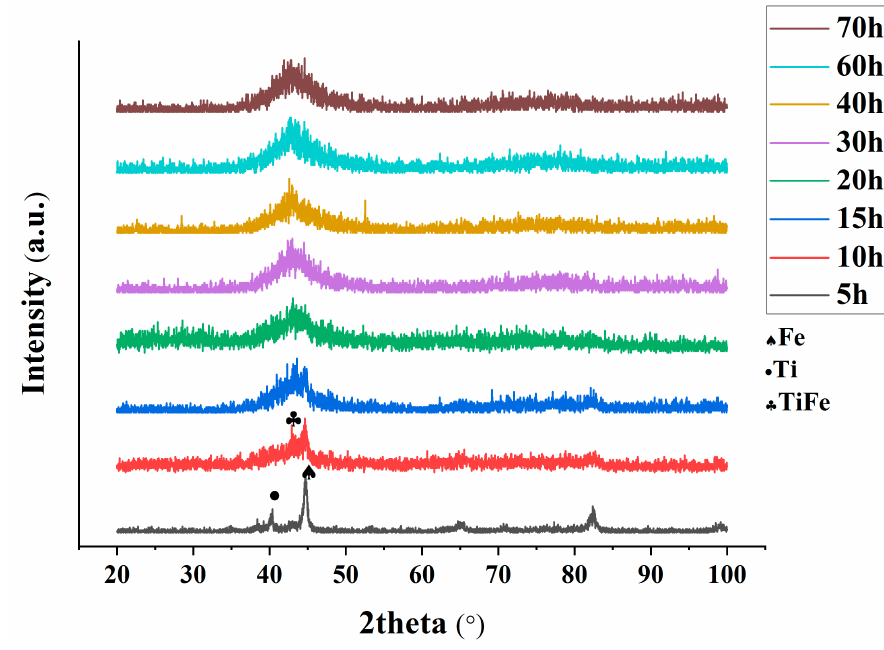
Figure 4. XRD patterns of Ti20 alloy after different milling times.